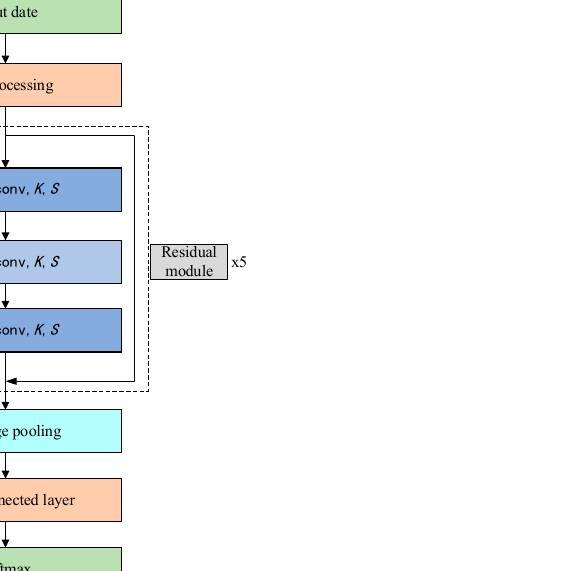
Figure 5. Simple residual network structure diagram with six residual modules.